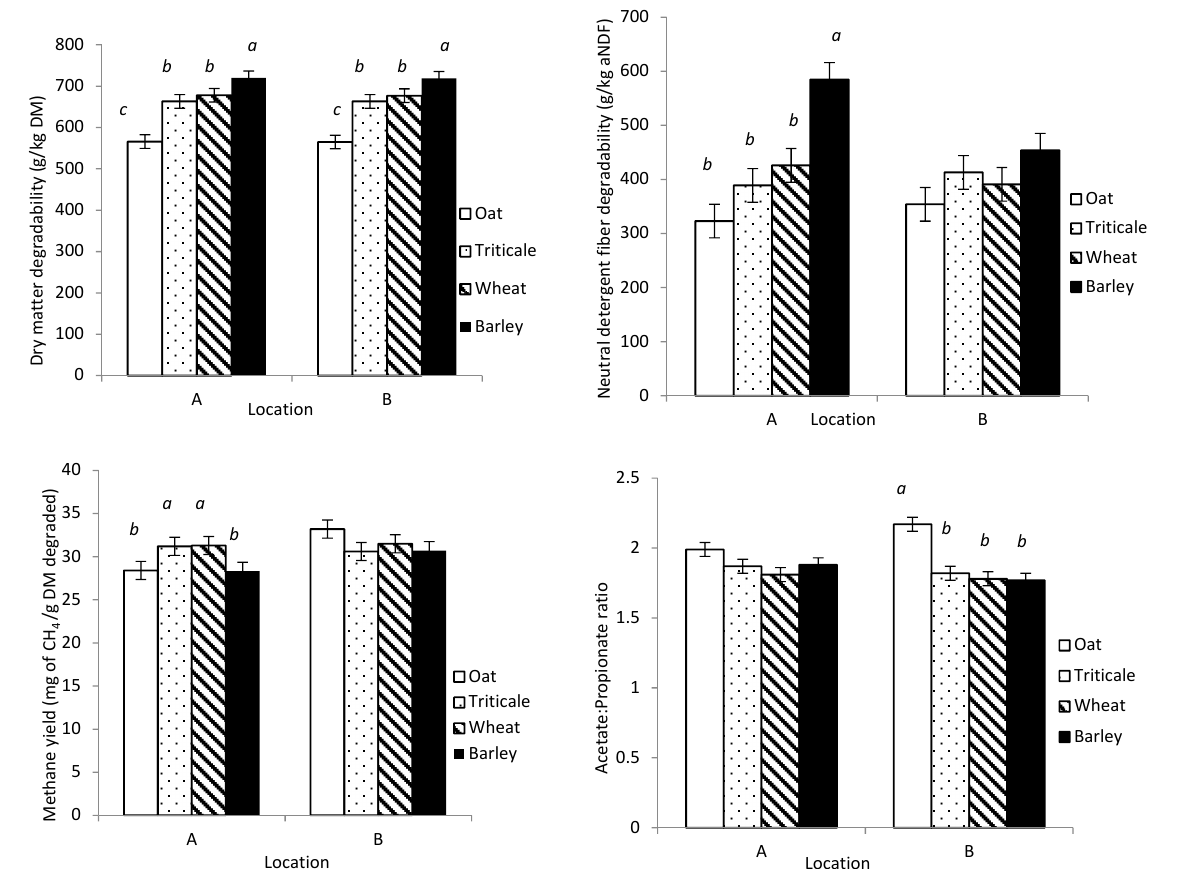
Figure 2. Dry-matter degradability ( upper left ); neutral detergent fiber degradability ( upper right ); methane yield ( lower left ); and acetate:propionate ratio ( lower right ) production of oat, triticale, wheat, and barley whole plants grown and harvested at two locations in central Alberta (A = Agriculture and Agri-Food Canada; B = Alberta Agriculture). Means without a common letter differ at p < 0.05 (a,b) within the different locations.